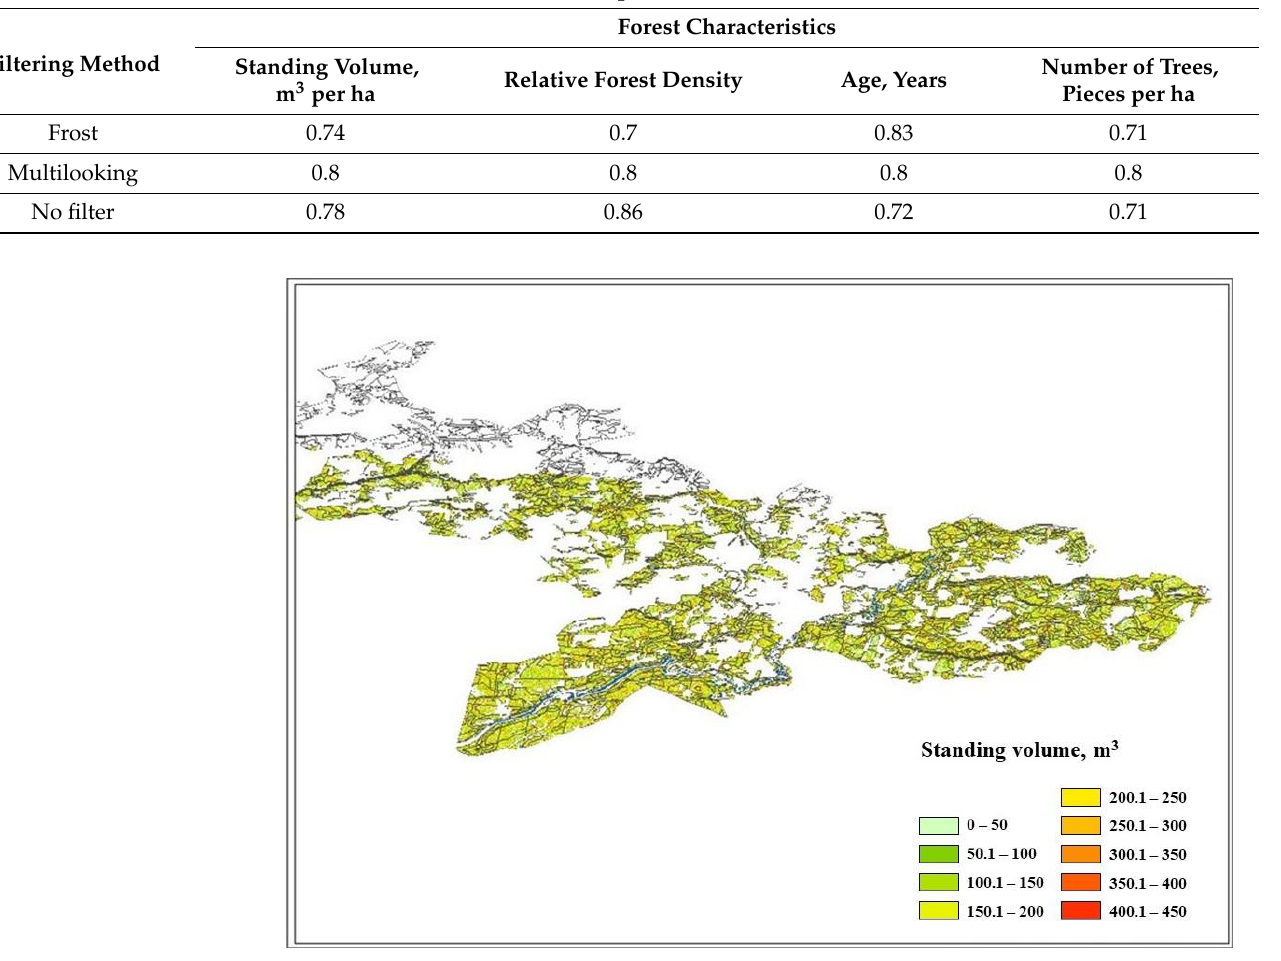
Figure 2. Deciphering standing volume according to radar survey data .